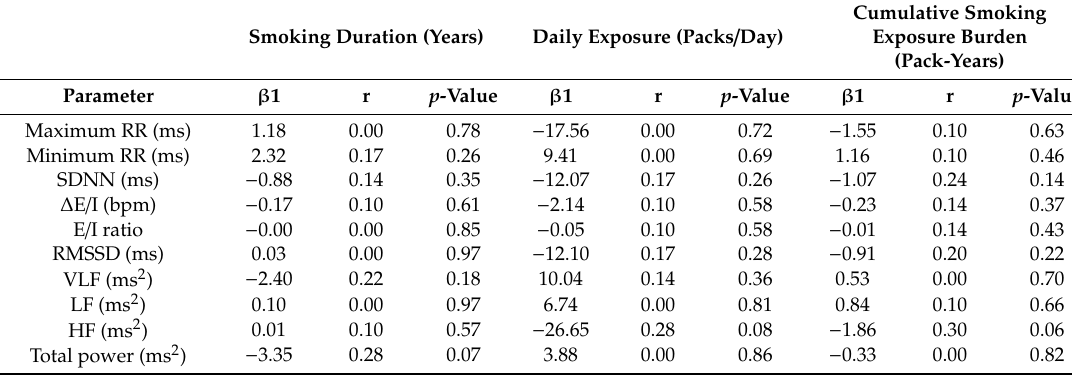
Table 5. Regression analysis between smoking burden and DBT parameters. Daily Exposure (Packs /